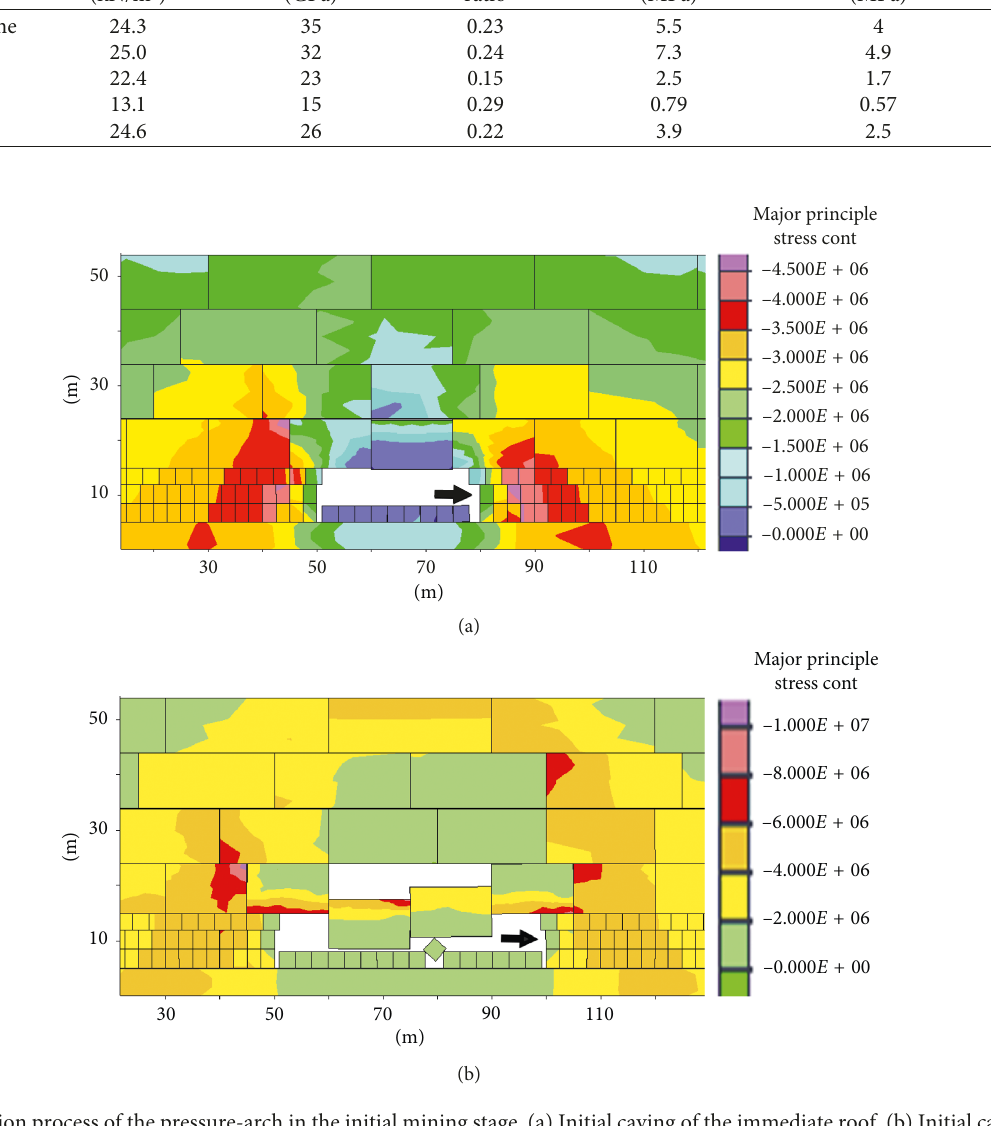
Figure 8: Evolution process of the pressure-arch in the initial mining stage. (a) Initial caving of the immediate roof. (b) Initial caving of the basic roof.